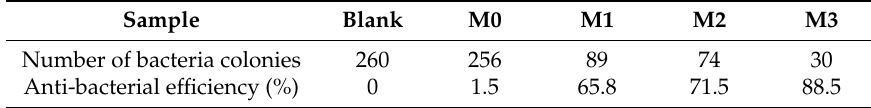
Figure 9. Photographs of the prepared membranes against S. aureus growth. Table 5. Anti-bacterial efficiency of the prepared membranes.